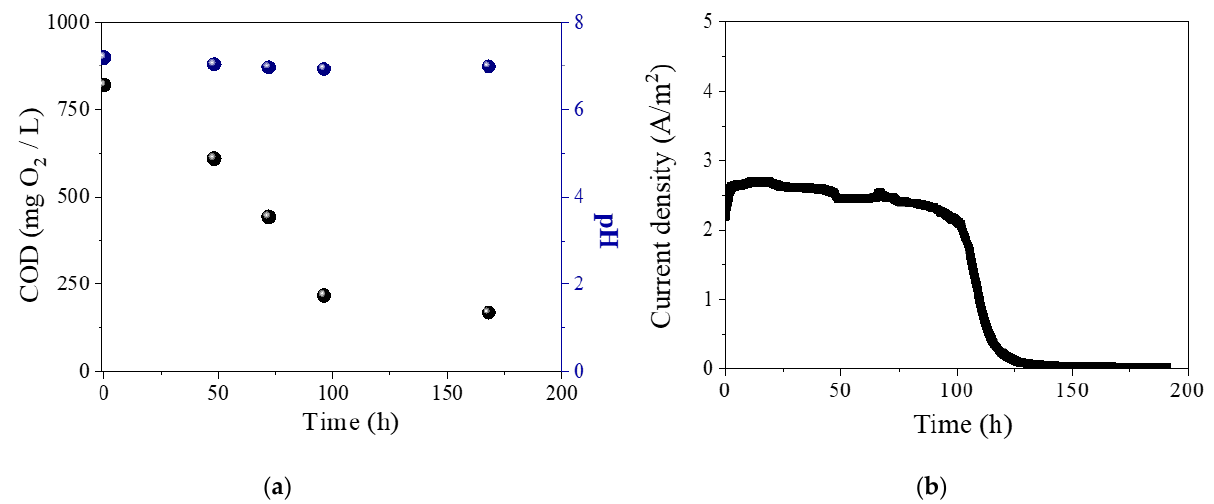
Figure 5. ( a ) COD, pH of the anolyte, and ( b ) current density (normalized to the anodic surface, 2 × 2 cm 2 ) for MEC2 vs. operation time, for an acetate-based synthetic wastewater feed. Applied cell potential: 0.9 V. Table 2. The main characteristics of both MECs for an acetate-based synthetic wastewater feed Characteristics